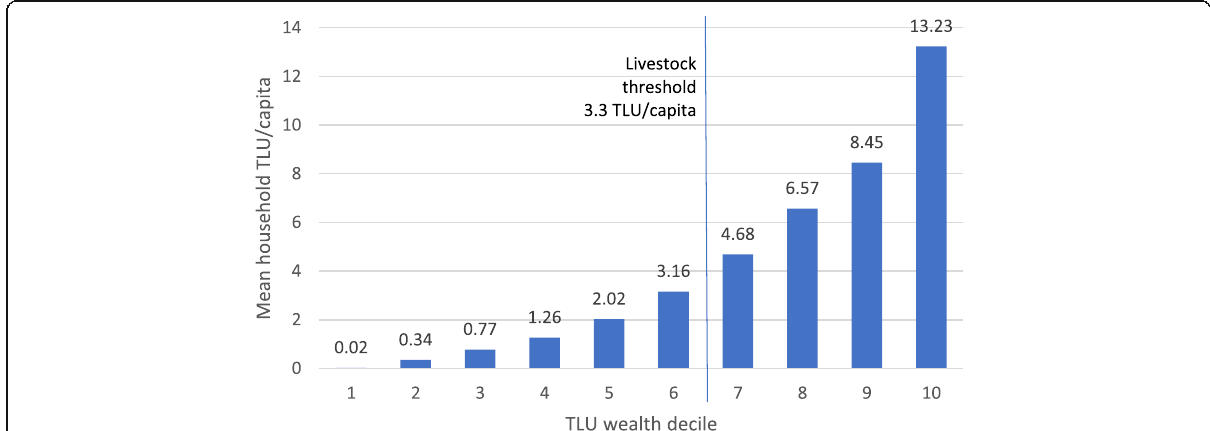
Fig. 2 Livestock ownership (TLU/capita) by wealth decile, Karamoja a , 2017. Notes: n = 2729 households. a Data derived from six districts as per Fig. 1